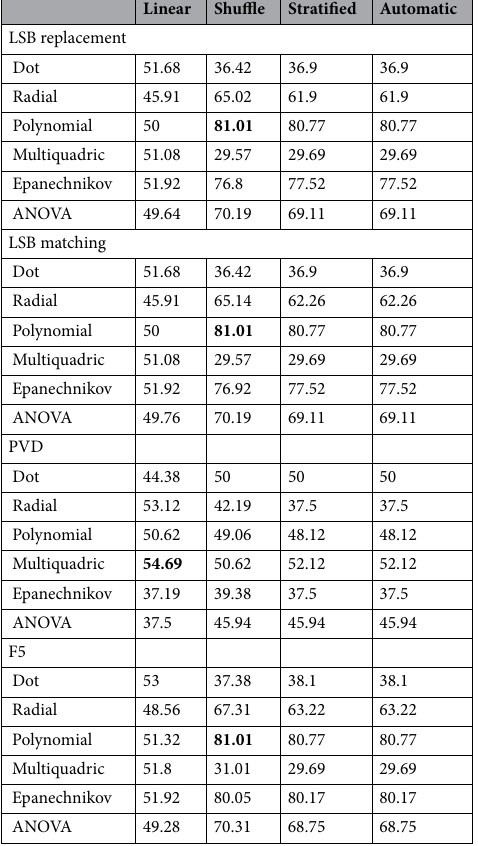
Table 6. Classification of calibrated images using SVM-PSO for random %. Significant values are in bold.